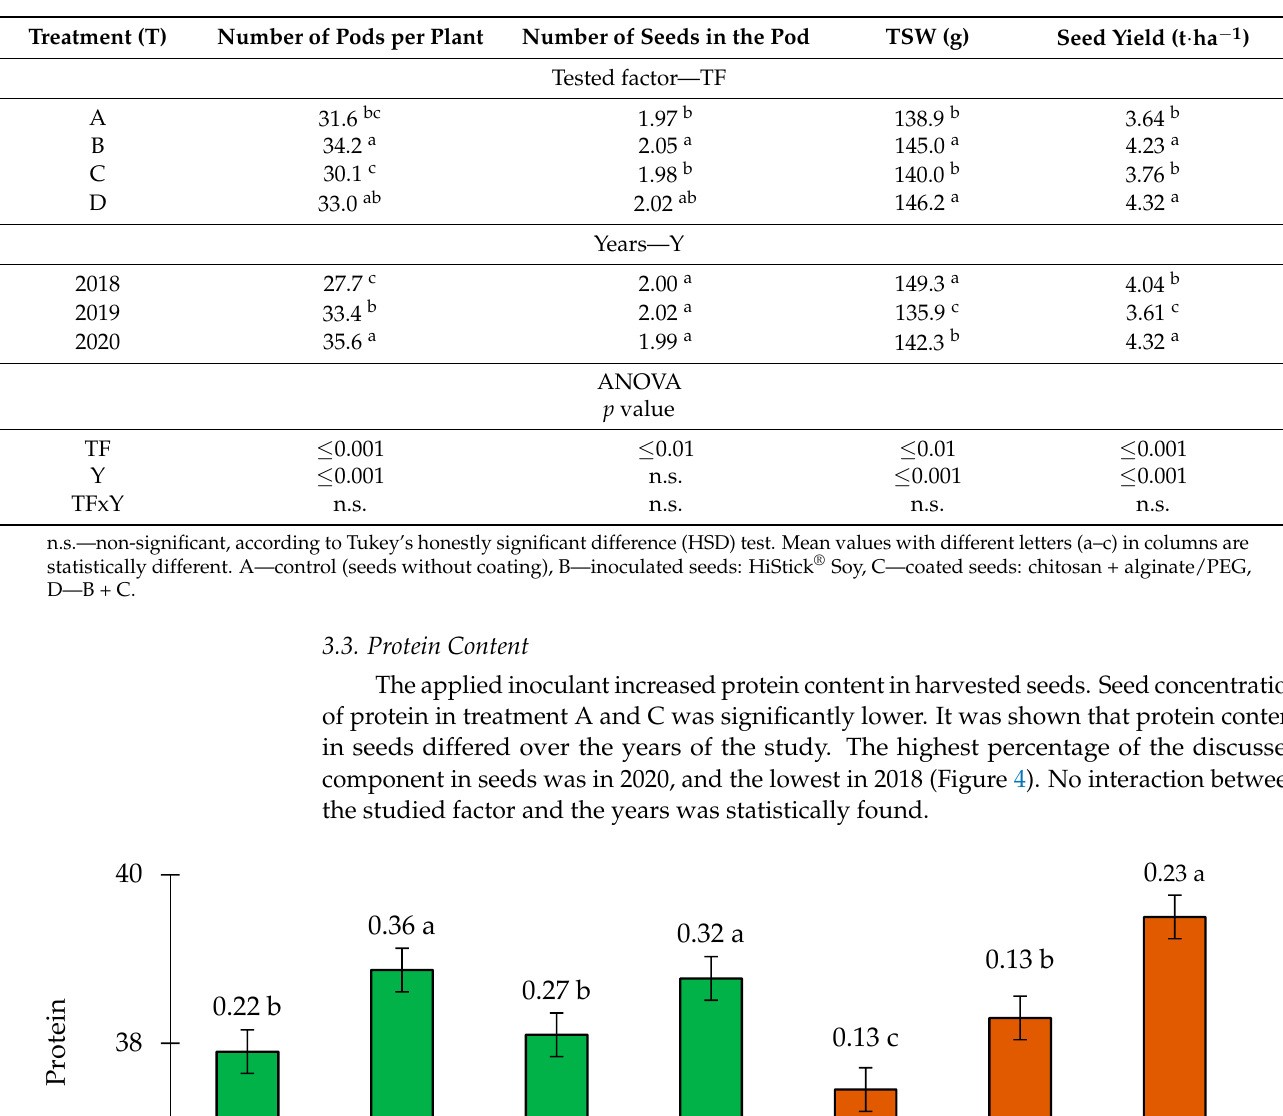
Table 4. Yield components and seed yield.